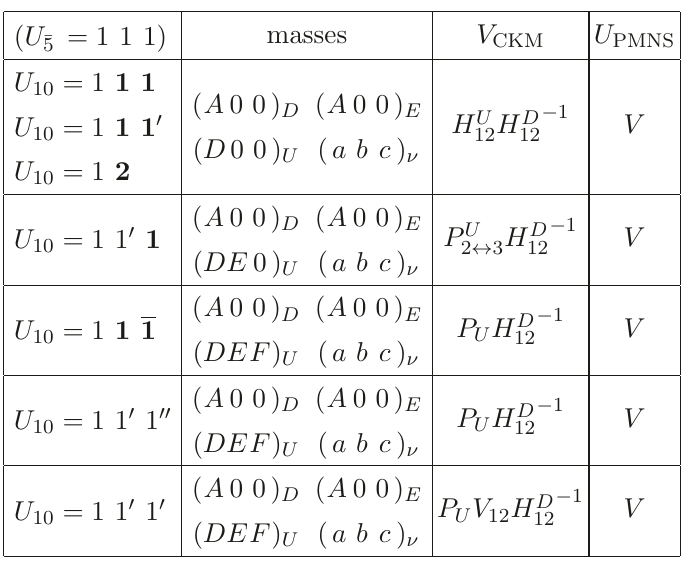
Table 6 . Possible forms of SU(5) unified flavour representations. U of fermion masses and of the CKM and PMNS matrices, in the notations of eq. (4.1), corresponding to viable choices are shown. The lepton mass pattern and PMNS matrix are all in the same form, as they all correspond to the case in the first line of table 4. P 2 ↔ 3 is either the identity permutation or the switch of 2 and